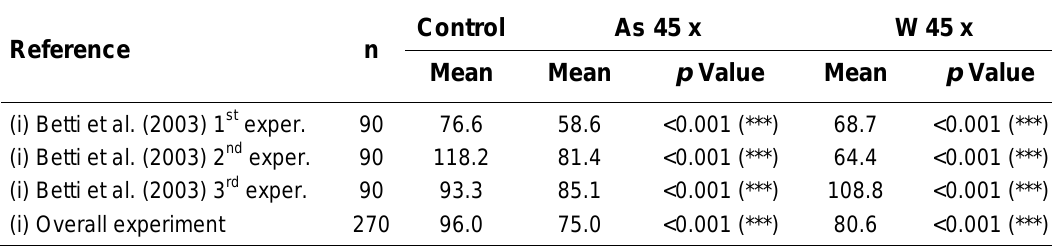
Tobacco/TMV Interaction: Mean Number of Necrotic Lesions and Wilcoxon Test Significance Reference